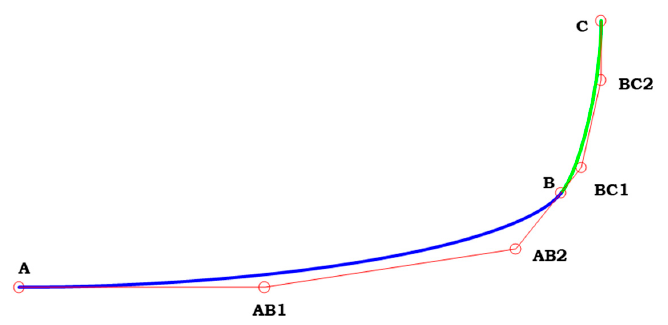
Figure 3. Two rational Bézier curves with a point in common.